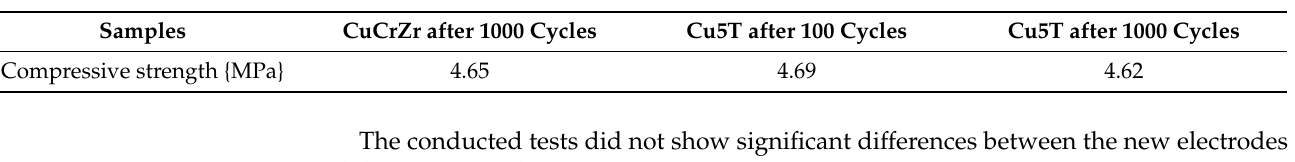
Table 3. Compressive strength test